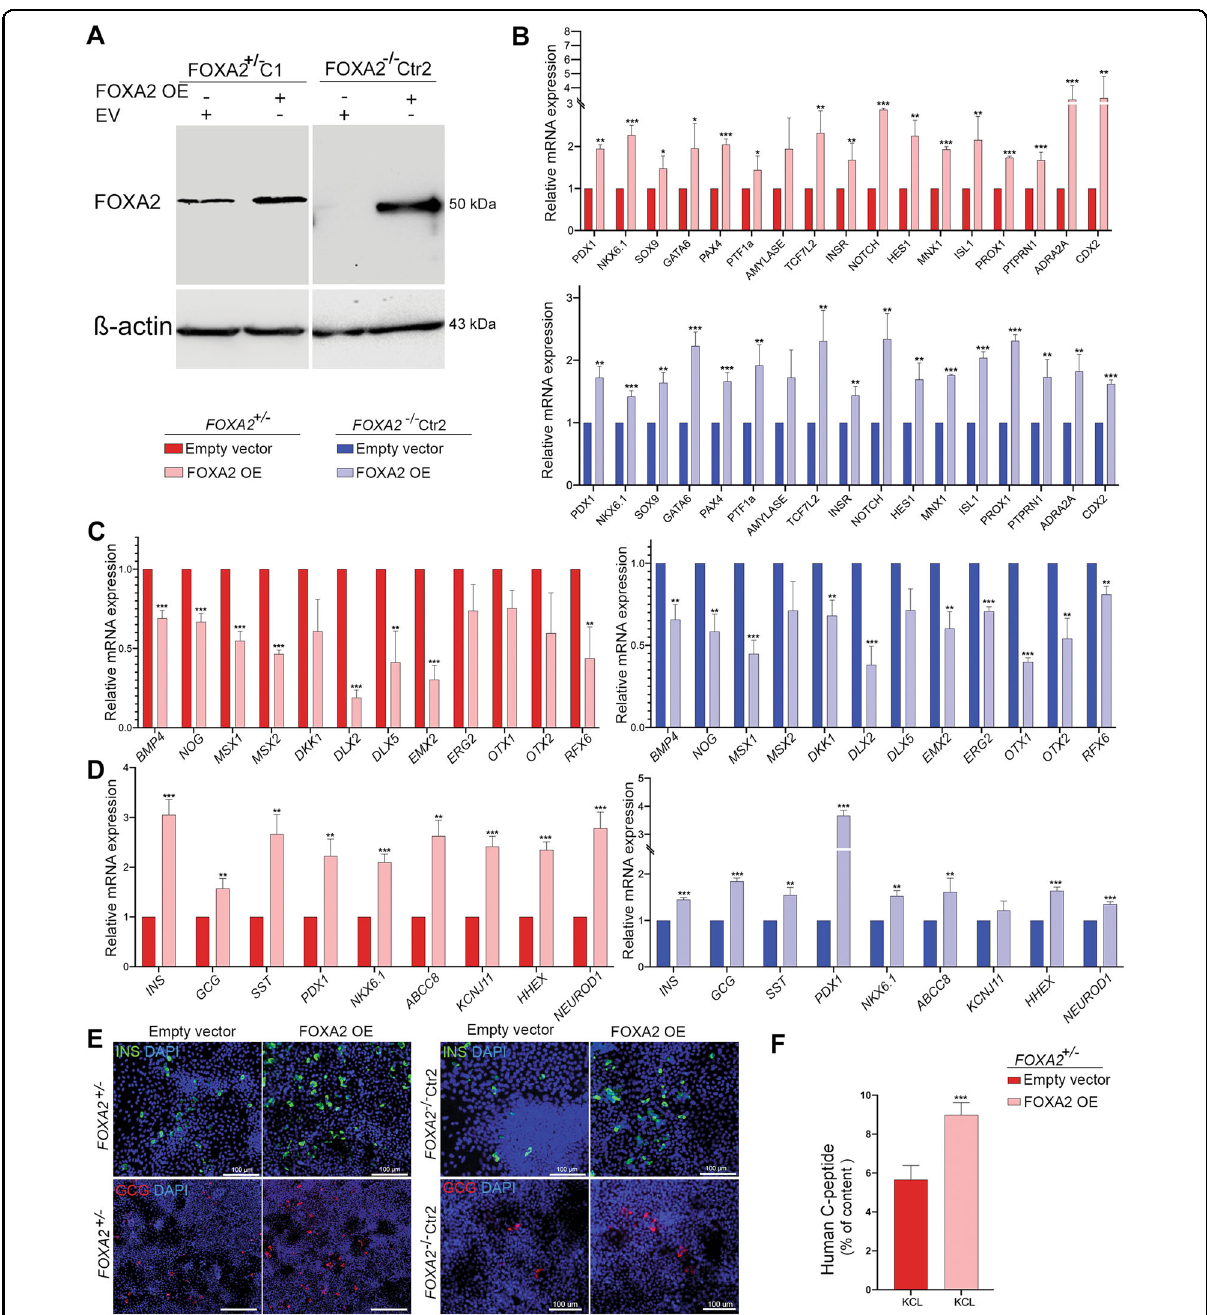
Fig. 8 FOXA2 overexpression in PP2 reverse the phenotype of FOXA2 de fi ciency. A Representative western blotting showing the overexpression of FOXA2 in the PP2 derived from FOXA2 + / − iPSCs, and FOXA2 − / − iPSCs, 48 h after transfection with FOXA2 plasmid or empty vector (EV). B Real-time PCR analysis for the expression of PDX1 , NKX6.1 , SOX9 , GATA6 , PAX4 , PTF1A , AMYLASE , TCF7L2 , INSR , NOTCH , HES1 , MNX1, ISL1, PROX1, PTPRN1, ADRA2A , and CDX2 in PP2 derived from FOXA2 + / − iPSCs and FOXA2 − / − iPSCs 48 h after transfection. C Real-time PCR analysis for the expression of BMP4 , NOG , MSX1 , MSX2 , DKK1 , DLX2 , DLX5 , EMX2 , ERG2 , OTX1 , OTX2 , and RFX6 in PP2 derived from FOXA2 + / − iPSCs and FOXA2 − / − iPSCs 48 h after transfection. D Real-time PCR analysis for the expression of INS , GCG , SST , PDX1 , NKX6.1 , ABCC8 , KCNJ11 , HHEX , and NEUROD1 in stage 7 derived from FOXA2 + / − iPSCs and FOXA2 − / − iPSCs transfected with FOXA2 plasmid or EV at stage 4. E Representative immuno fl uorescence images showing the expression of INS and GCG in stage 7 derived from FOXA2 + / − iPSCs and FOXA2 − / − iPSCs transfected with FOXA2 plasmid or EV at stage 4. F C-PEPTIDE (C-PEP) secretion (% of content) after stimulation with or without 30 mM KCl in the presence of low glucose (LG) in FOXA2 + / − iPSC- derived beta cells transfected with FOXA2 plasmid or EV at stage 4. The data are presented as mean ± SD. * p < 0.05, ** p < 0.01, *** p <